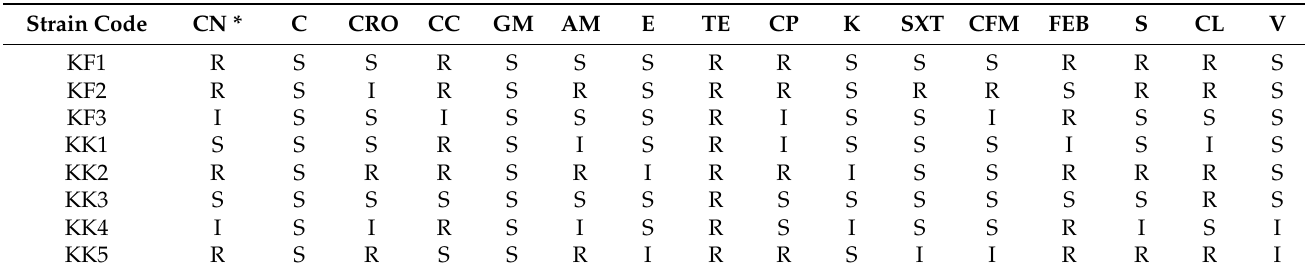
Table 5. Antibiotic sensitivity of LAB isolates of Abadeh (Fars) and Kalat (Razavi Khorasan) kashk